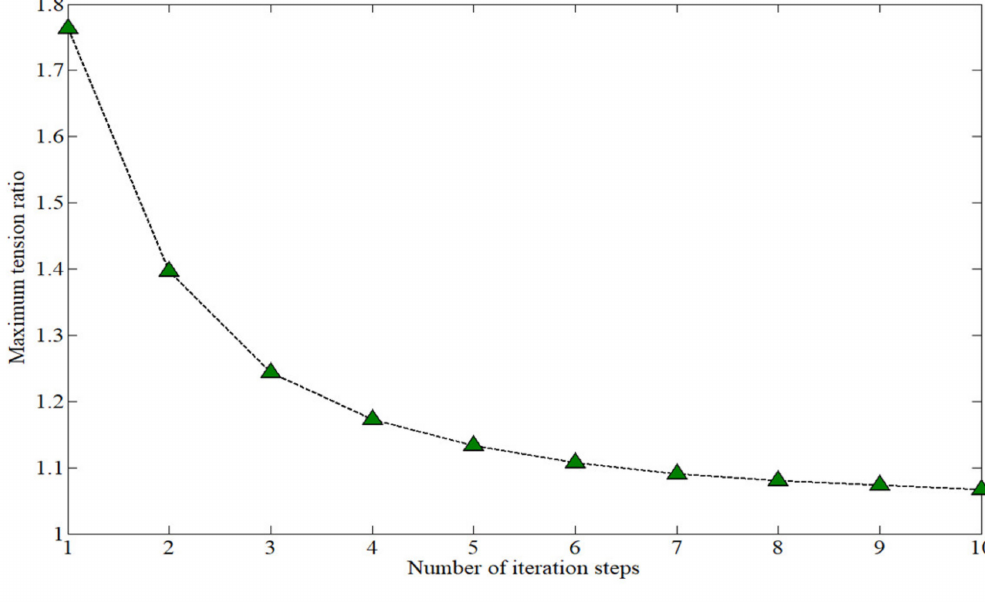
Figure 3. Maximum tension